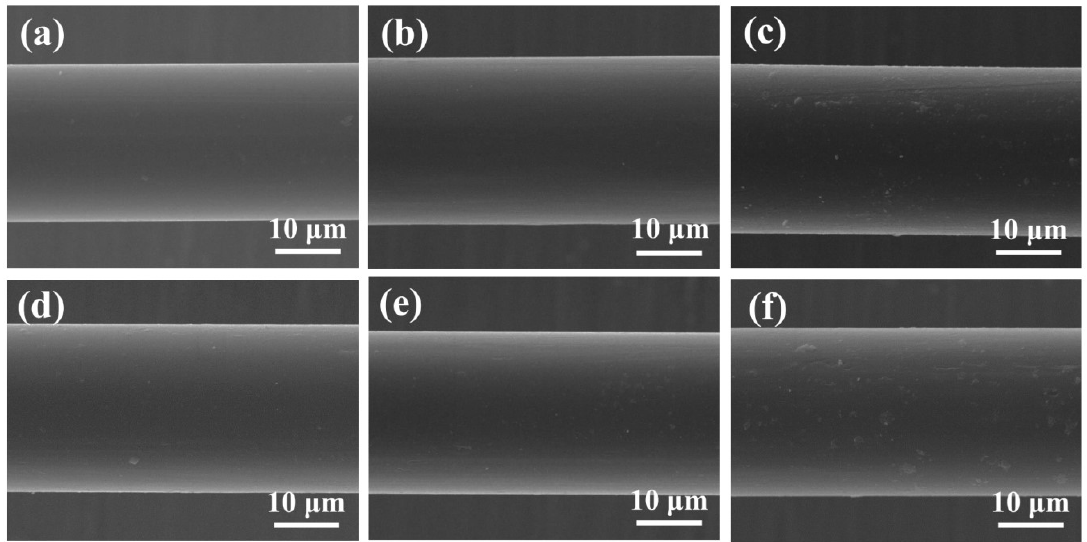
Figure 5. SEM images of poly(ether ether ketone) (PEEK) fibers at different plasma treatment times: ( a ) untreated PEEK fiber, ( b ) PEEK–AA15, ( c ) PEEK–air, ( d ) PEEK–Ar, ( e ) PEEK–AA1, and ( f ) PEEK–AA5.